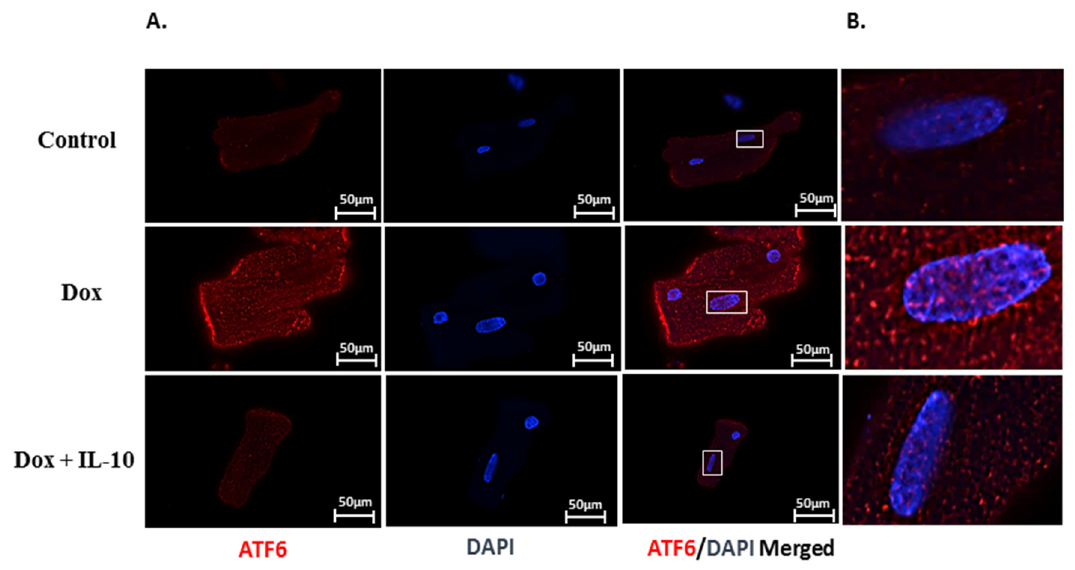
ence or absence of IL-10 (10 ng/mL) for 24 h. ( A ) Western blot of respective proteins using activat- ing transcription factor 6 α (ATF6 α ) (1:1000), inositol-requiring kinase 1 α (IRE1 α ) (1:2000), and protein kinase-like endoplasmic reticulum kinase (PERK) (1:500) antibodies . GAPDH was used as a loading control. Densitometric analysis of respective proteins ( B ) ATF6; ( C ) IRE1 α ; and ( D ) PERK. GAPDH was used as the loading control except for ATF6. Data are means +/ − SE from 3 individual